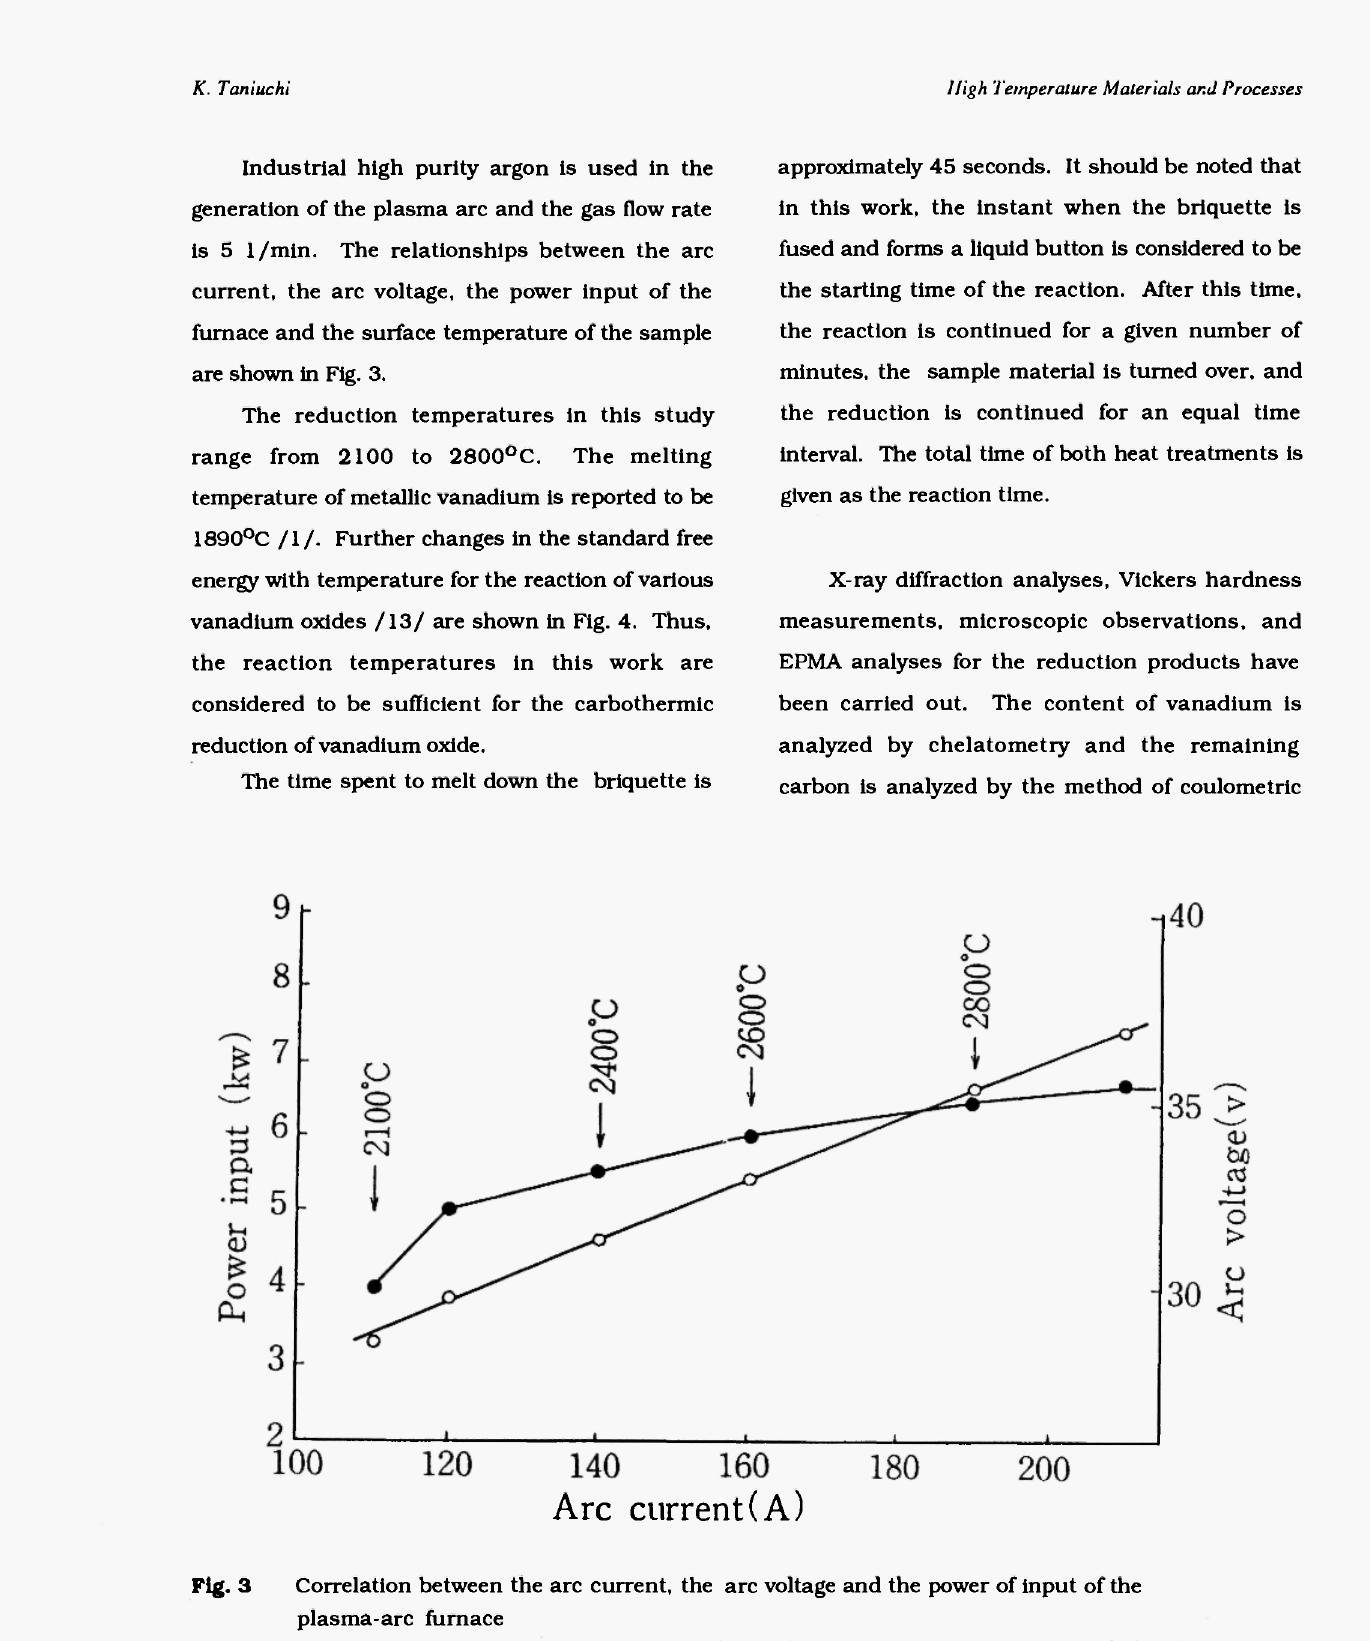
Fig. 3 Correlation between the arc current, the arc voltage and the power of input of the plasma-arc